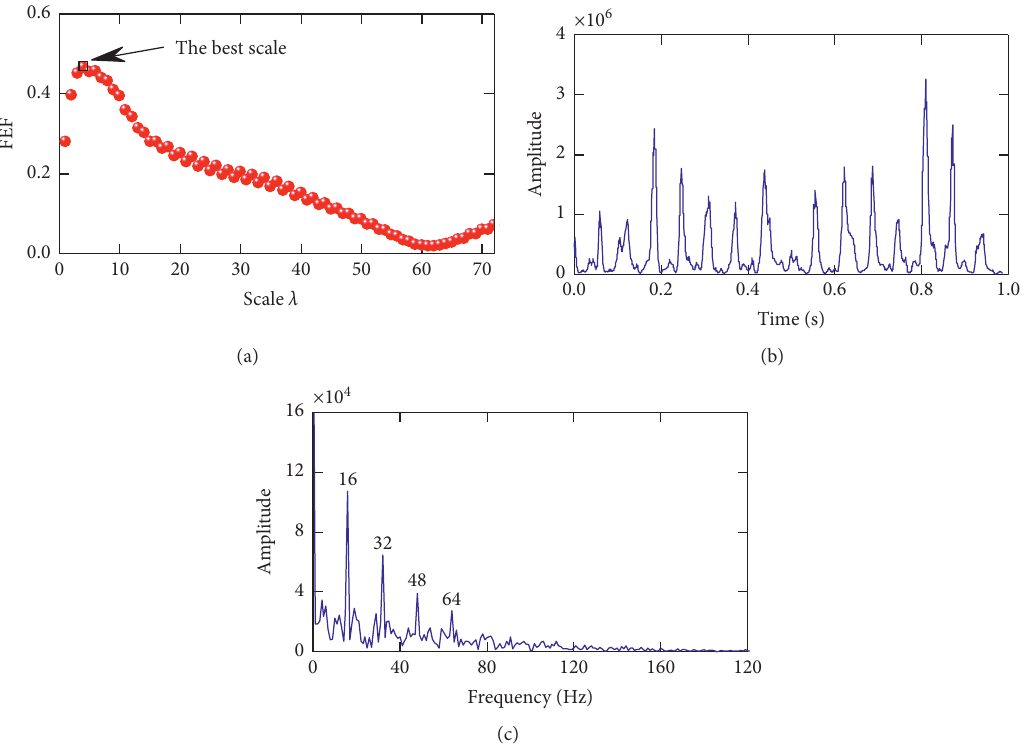
Figure 9: Case1: (a) correlation curve between FEF and scale λ ; (b) time-domain spectrum processed by the EMDF method; (c) frequency- domain spectrum processed by the EMDF method.